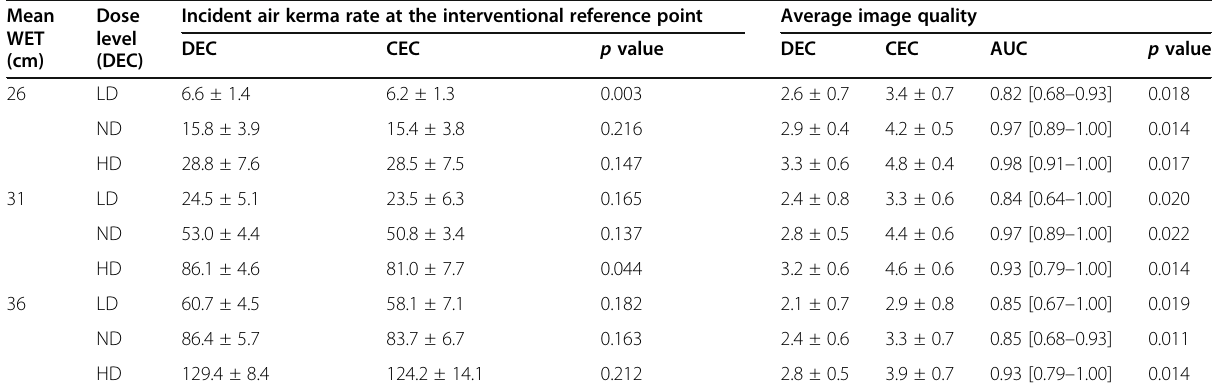
Table 4 Incident air kerma rate at the interventional reference point and average image quality of all three readers of fluoroscopic images acquired with detector dose-driven exposure control (DEC) and Ta-specific contrast-to-noise ratio-driven exposure control (CEC), while maintaining the incident air kerma rate